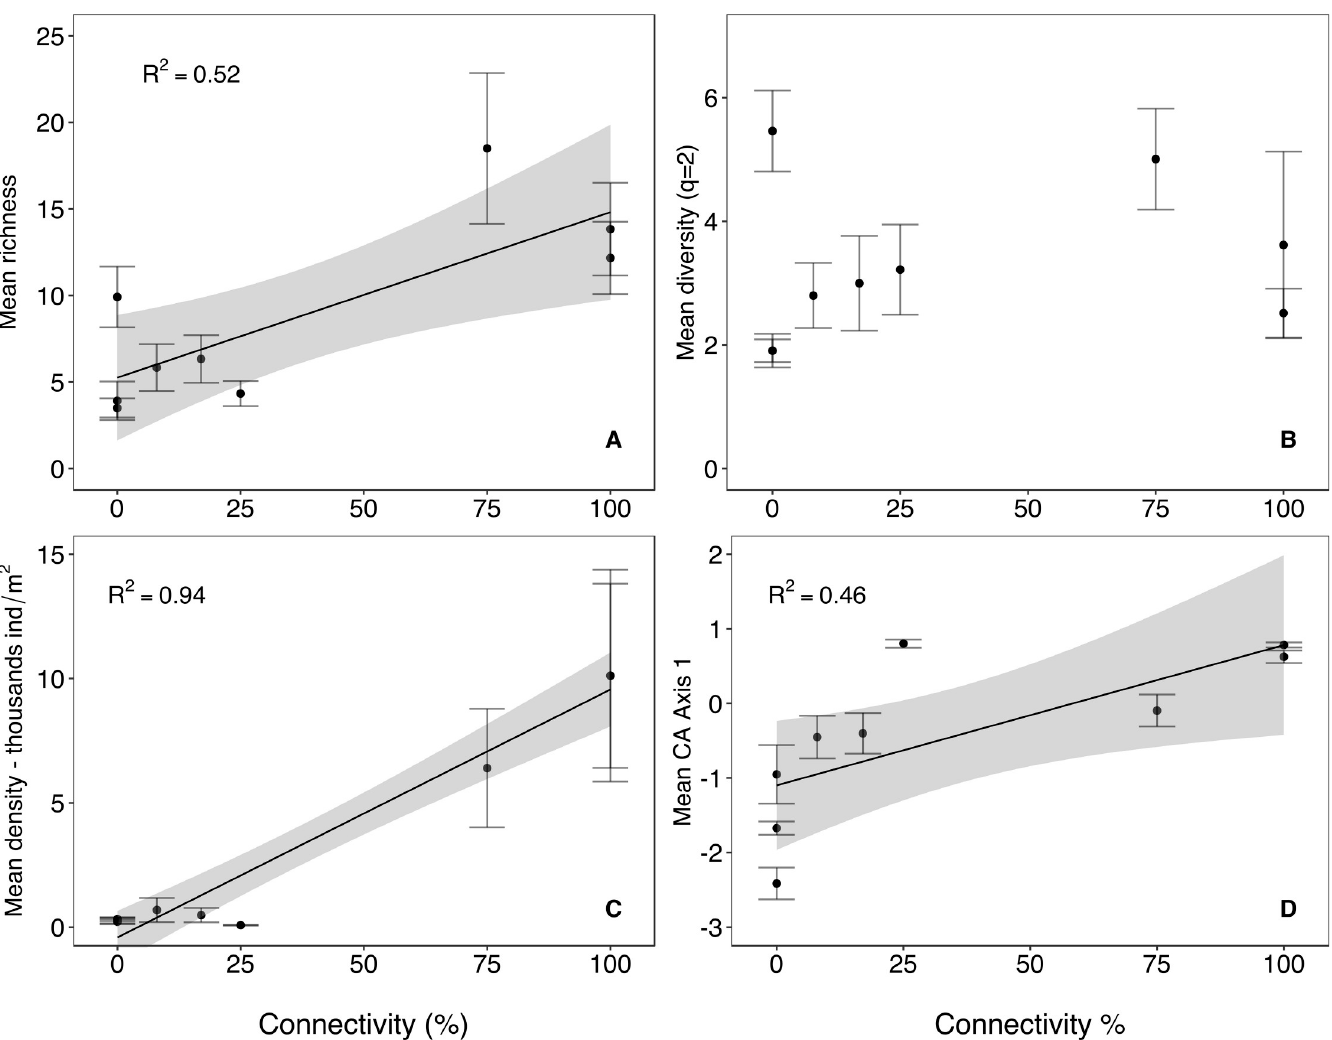
Fig 3. Biodiversity–connectivity relationships. Relationship between mean ( ± SE) taxonomic richness (A), mean diversity of order q = 2 (B), mean density (C) and mean CA (Correspondence Analysis) axis 1(D) with lateral hydrologic connectivity across nine waterbodies in the Tagliamento floodplain (NE Italy). Grey area = 0.95 confidence interval of